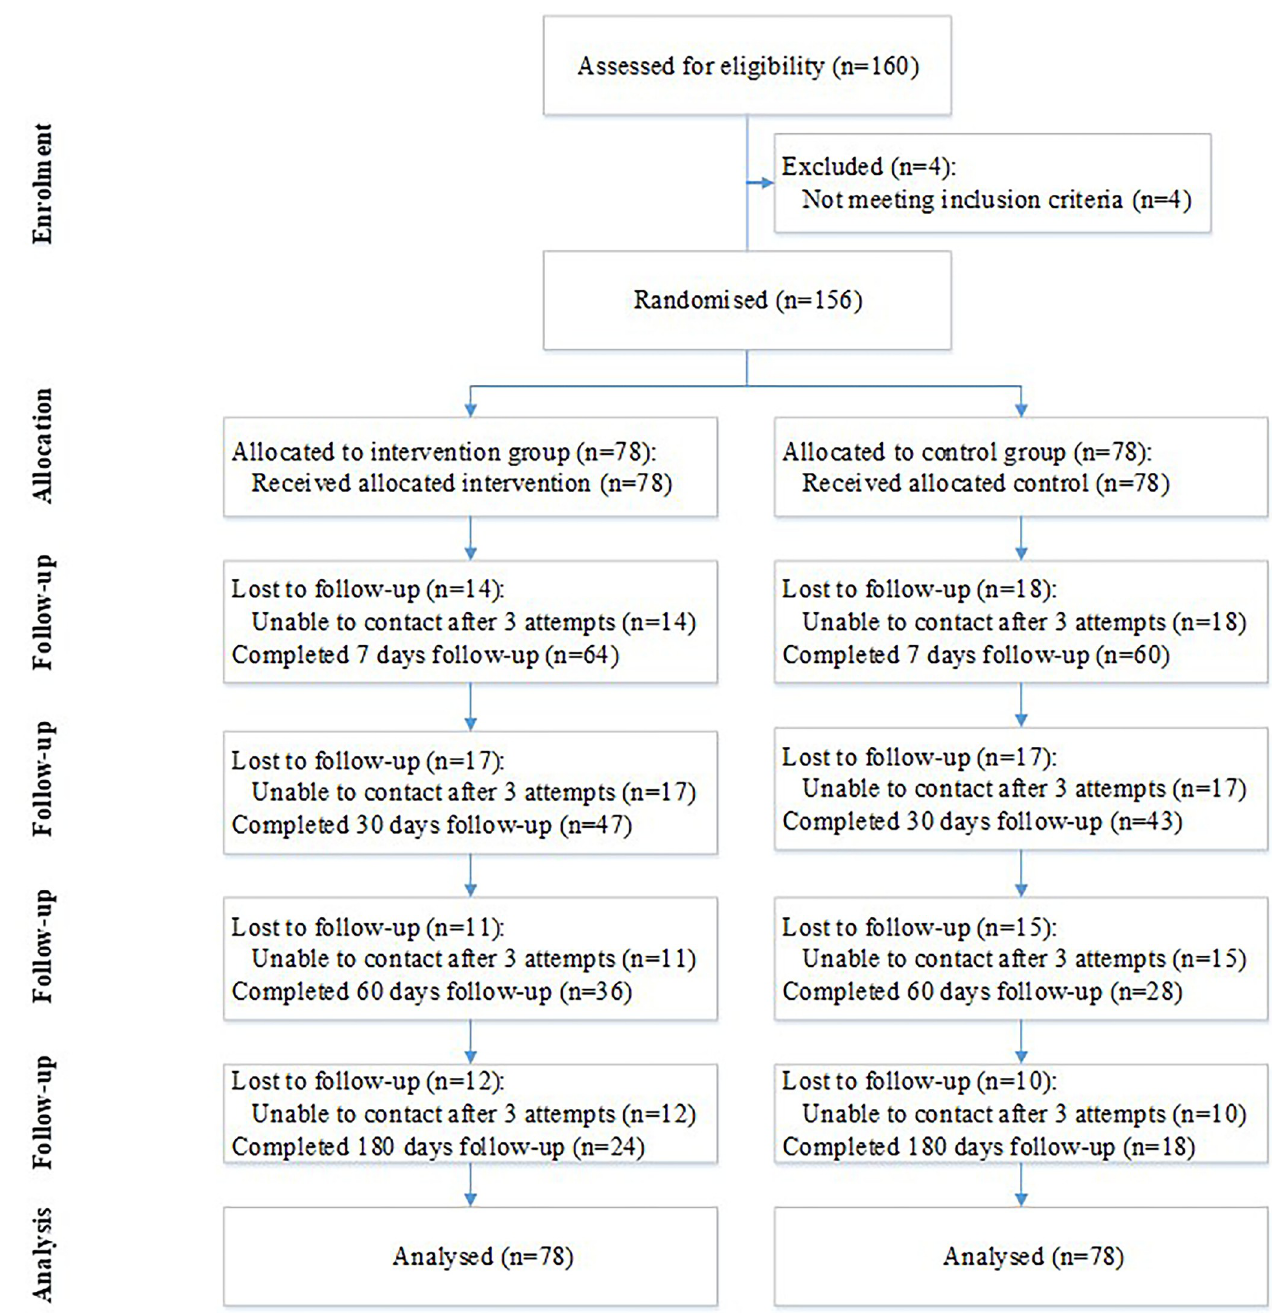
Fig 1. Participant